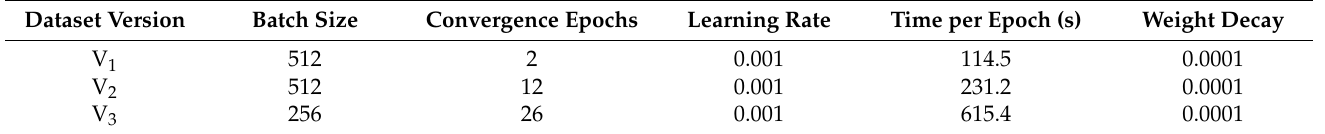
Table 4. The hyperparameters of the QPENet